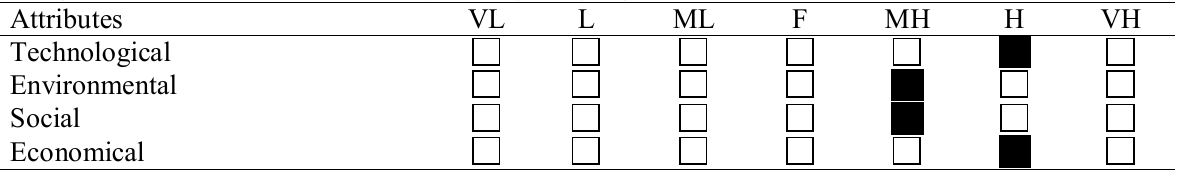
Weights of four attributes obtained by the experts' judgments